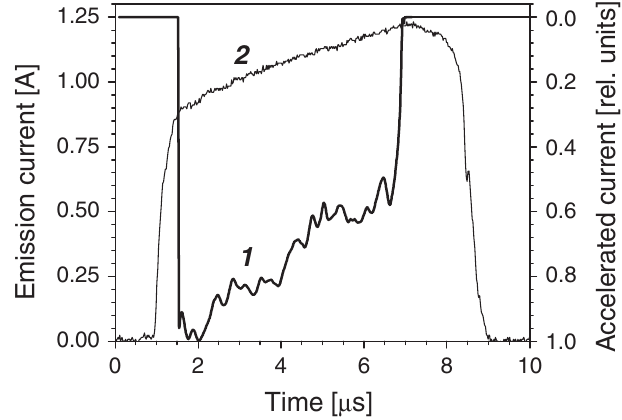
FIG. 4. Calculated shape of the accelerated current, curve 1, right scale, vs the time-dependent measured emission current, curve 2, and left